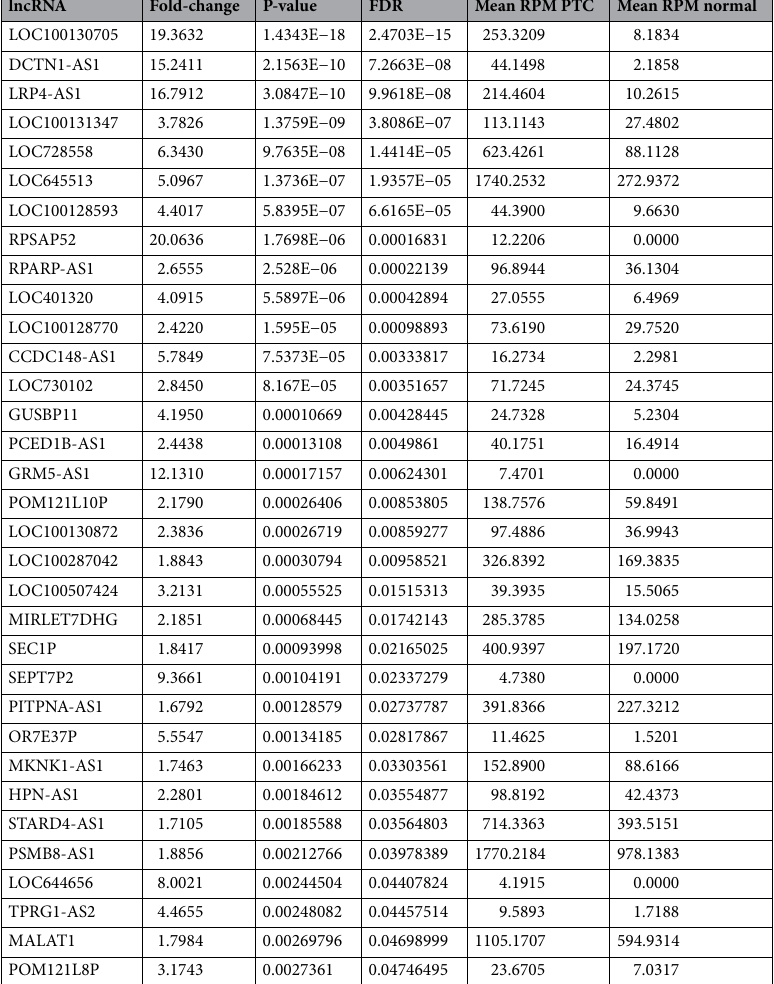
Table 1. Overexpressed lncRNAs (false discovery rate < 0.05; fold change >